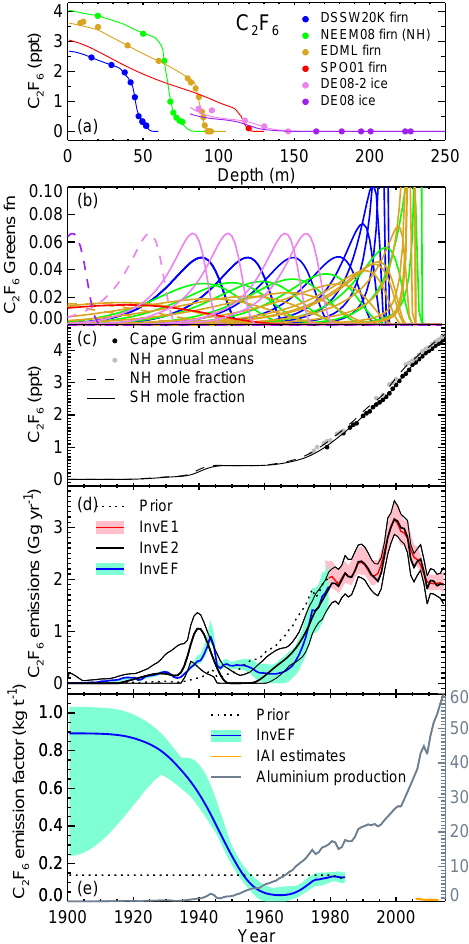
Figure 3. Inputs and results for the C 2 F 6 inversions. Panels, line styles and symbols are as in Fig. 2, except that Green’s functions in (b) are dashed if the measured mole fraction is zero (or below detection).